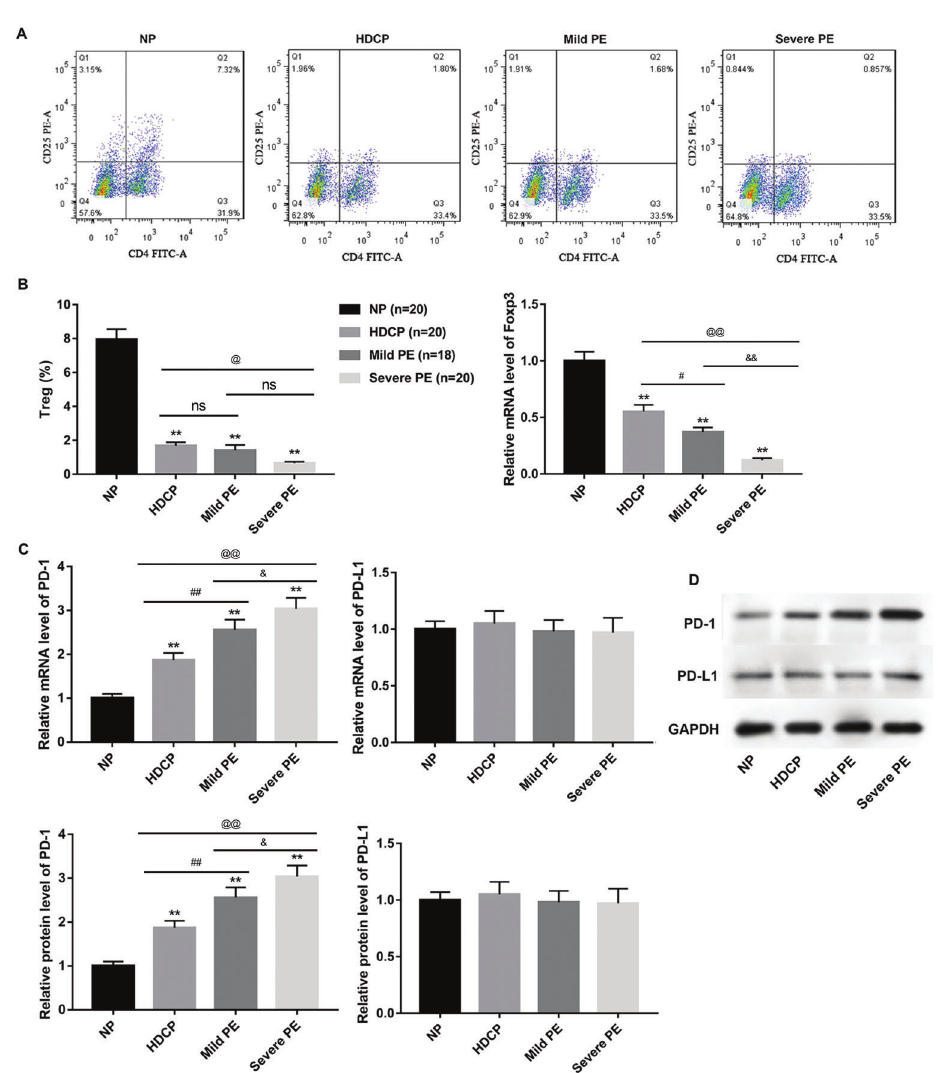
Figure 2. Expression of Treg and Foxp3 as well as PD-1/PD-L1 expression in Treg cells. Peripheral blood mononuclear cells were isolated from the venous blood of women with normal pregnancy (NP), hypertensive disorder complicating pregnancy (HDCP), mild preeclampsia (PE), and severe PE by density gradient centrifugation. A , The percentage of Treg cells was assessed by fl ow cytometry. B , The mRNA level of Treg-speci fi c transcript factor Foxp3 was evaluated by qRT-PCR. C and D , The mRNA and protein levels of PD-1 and PD-L1 in CD4 + CD25 + Treg cells were assessed by qRT-PCR and western blot, respectively. Data are reported as means ± SD. **P o 0.01 vs NP; # P o 0.05, ## P o 0.01 mild PE vs HDCP; @ P o 0.05, @@ P o 0.01 severe PE vs HDCP; & P o 0.05, && P o 0.01 mild PE vs severe PE; ns: not signi fi cant ( t